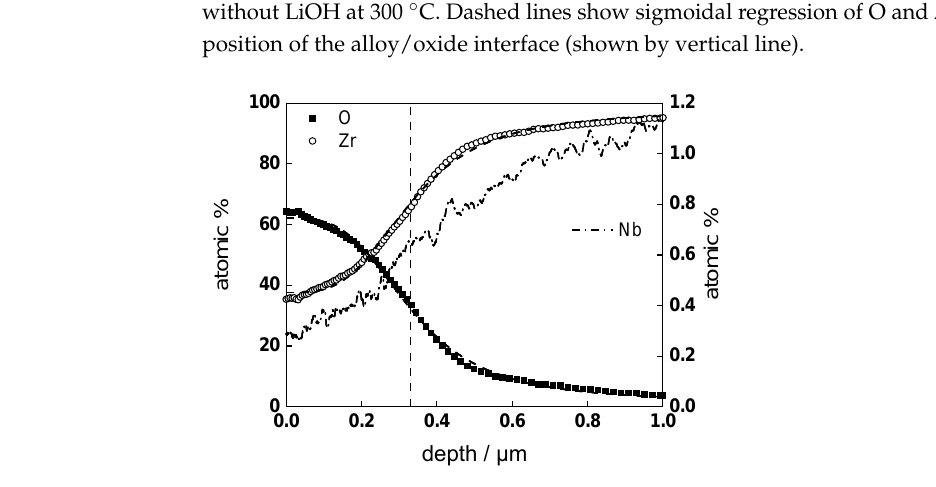
Figure 7. Elemental composition profile of the oxide on Zr-1%Nb alloy formed for 720 h in WWER coolant with LiOH at 300 °C. Dashed lines show sigmoidal regression of O and Zr profiles to estimate the position of the alloy/oxide interface (shown by vertical line).